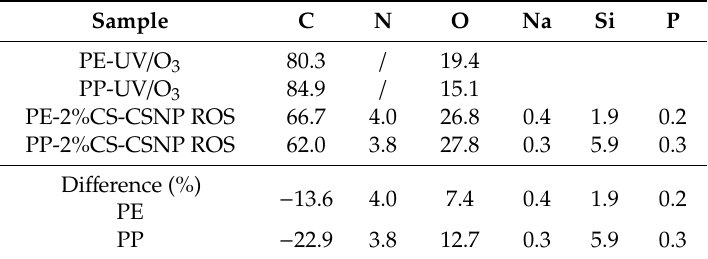
Table 7. Surface chemical composition (at. %) of the reference foils and foils treated by the two-layer coating: PE-2%CS-CSNP